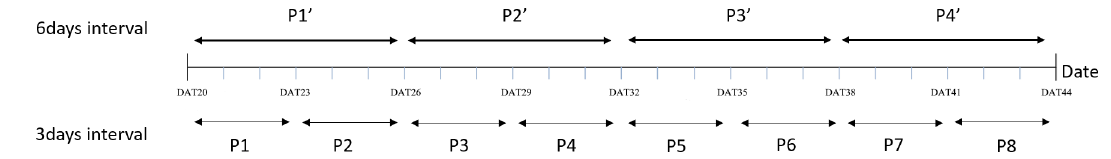
Fig 2. Establishment of data sets. P1 to P8 represent the data set calculated using a 3-day interval. P1’ to P4’ represent a data set calculated using a 6-day interval.